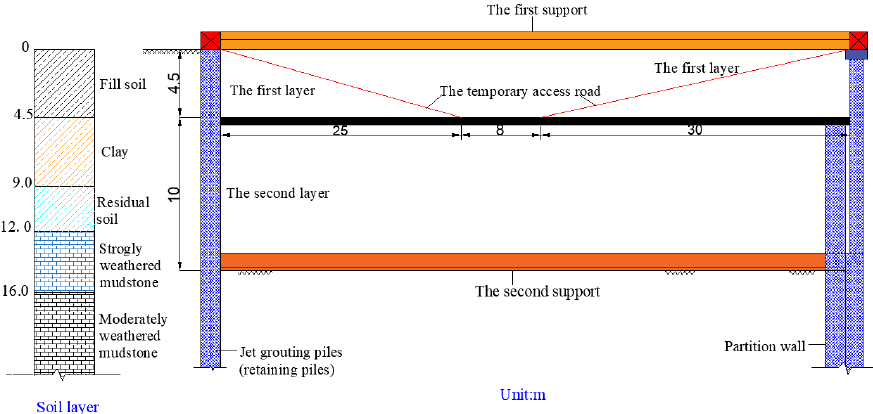
Figure 5. Supports design in the northern and southern districts.